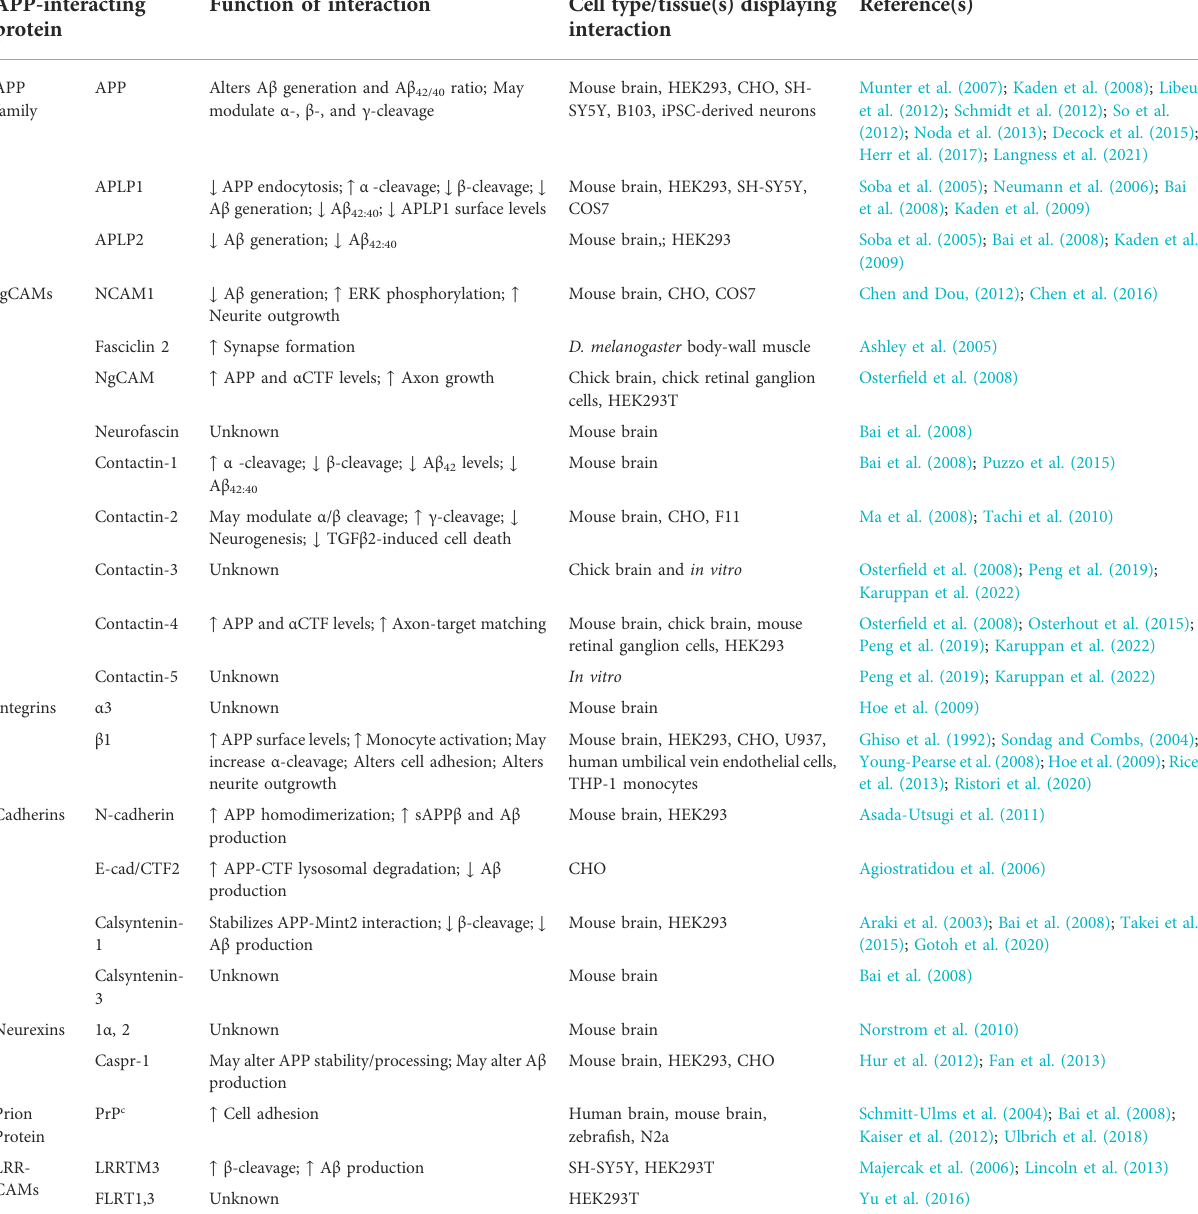
TABLE 1 APP-interacting cell adhesion molecules and their role in APP processing and physiological